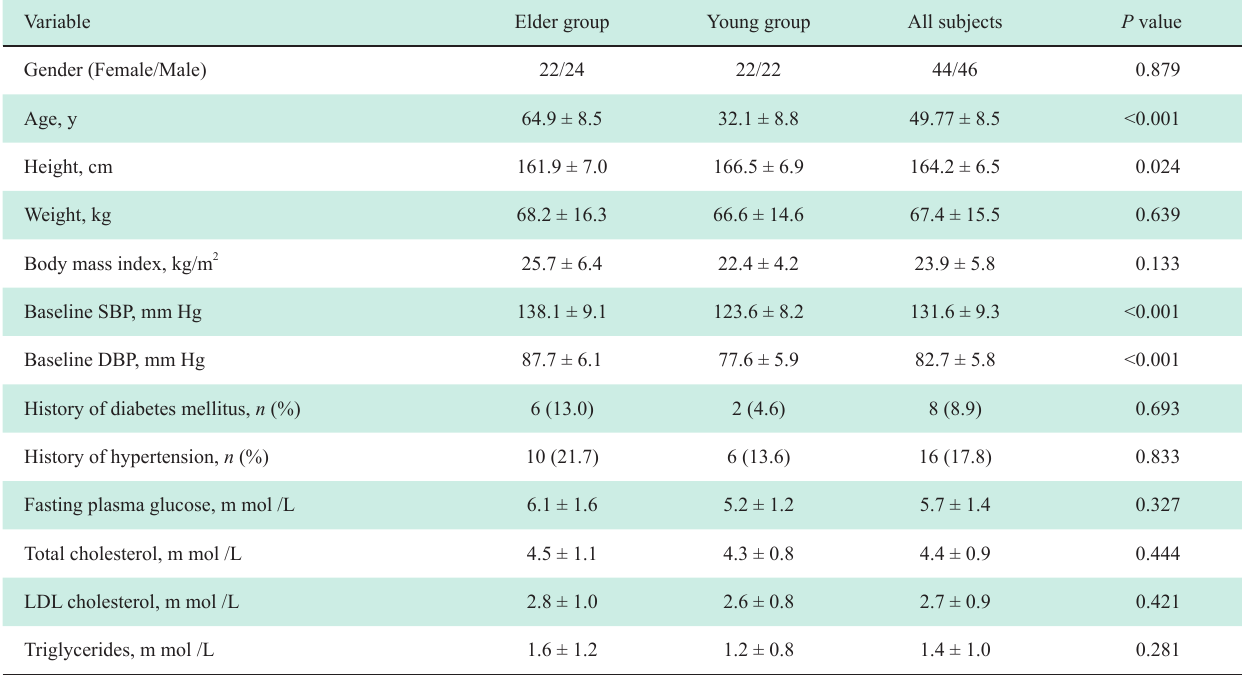
Table 1 Baseline and Clinical Data in healthy volunteers Variable Elder group Young group